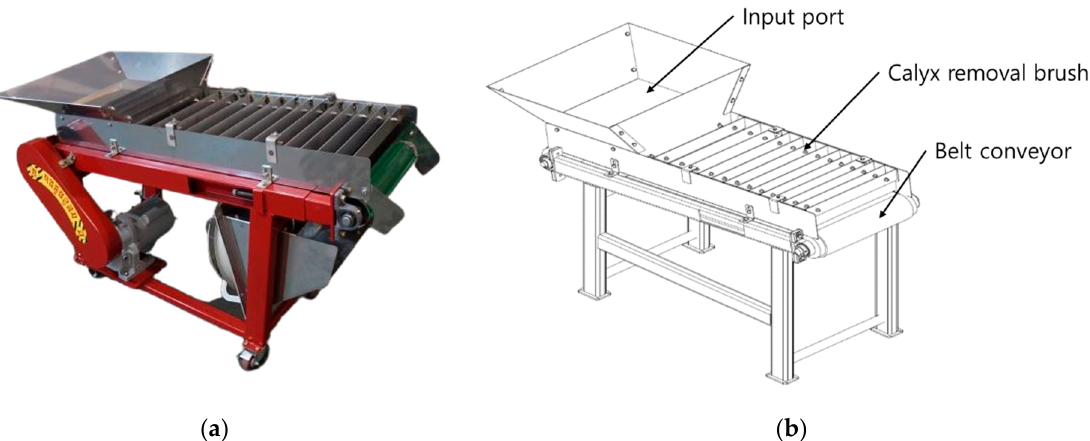
Figure 1. Prototype of the cherry tomato calyx remover ( a ) and three-dimensional design ( b ).